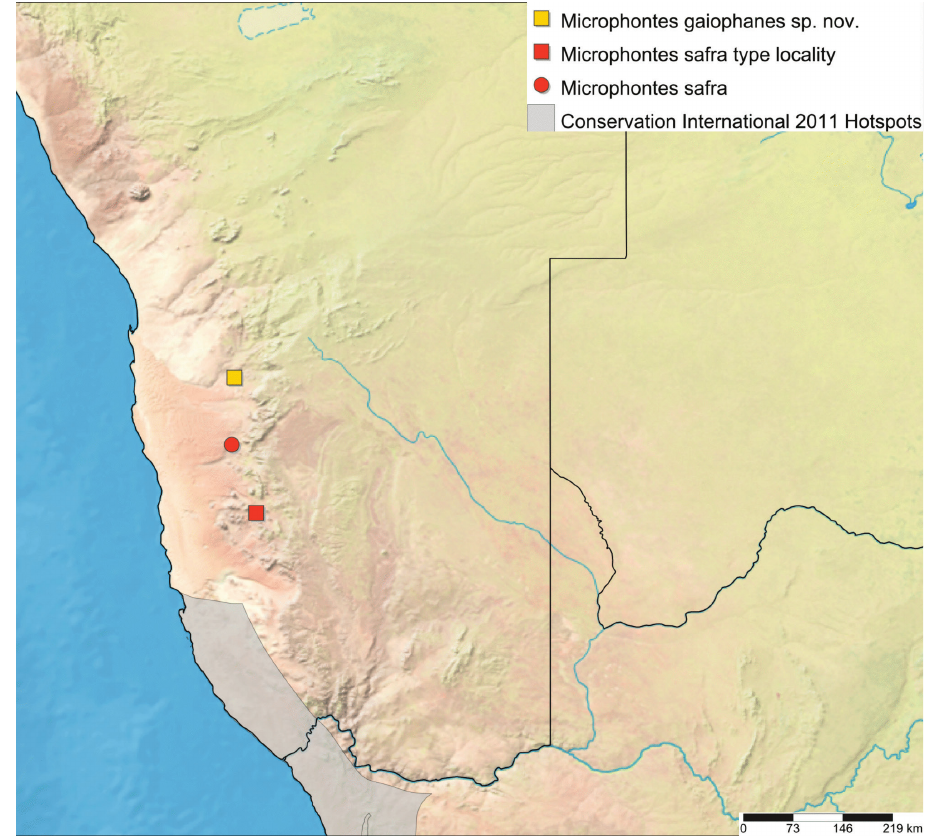
Figure 72. Map of Namibia with elevational relief, Biodiversity Hotspots ( sensu Conservation Inter- national) and distribution of Microphontes species occurring in Namibia (SimpleMappr 10599). Map data available in Google Earth KML file 10599 and also through GBIF (data-set http://www.gbif.org/ dataset/4c13483d-a2ac-4c61-9087-c4e1a3c7b91d, DOI